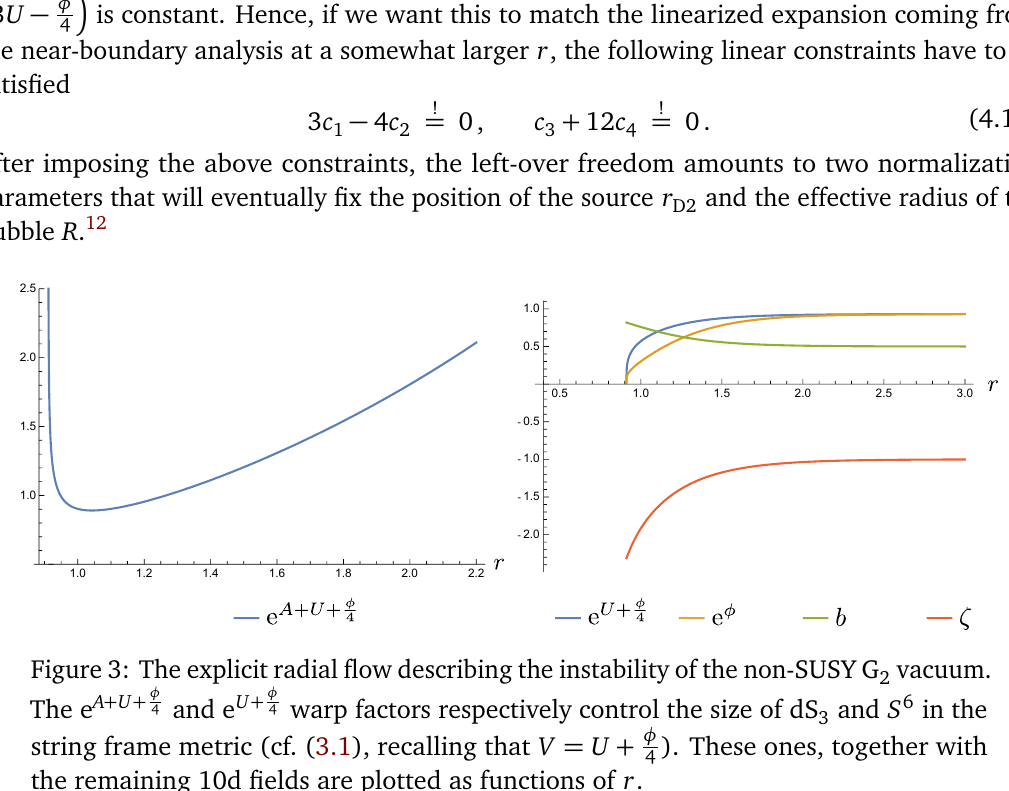
Figure 3: The explicit radial flow describing the instability of the non-SUSY G φ U + φ The e A + U + 4 and e 4 warp factors respectively control the size of dS 3 and S string frame metric (cf. (3.1), recalling that V = U + the remaining 10d fields are plotted as functions of r